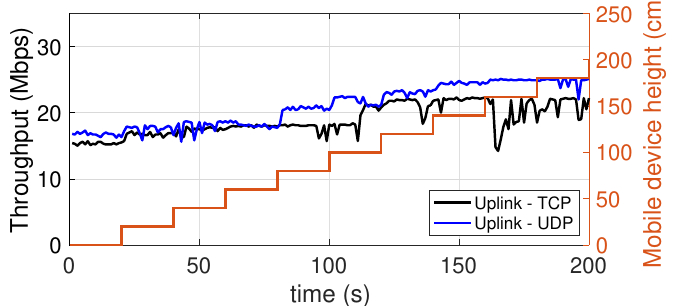
Figure 17. Uplink throughput with the mobile device placed at different heights. TCP and